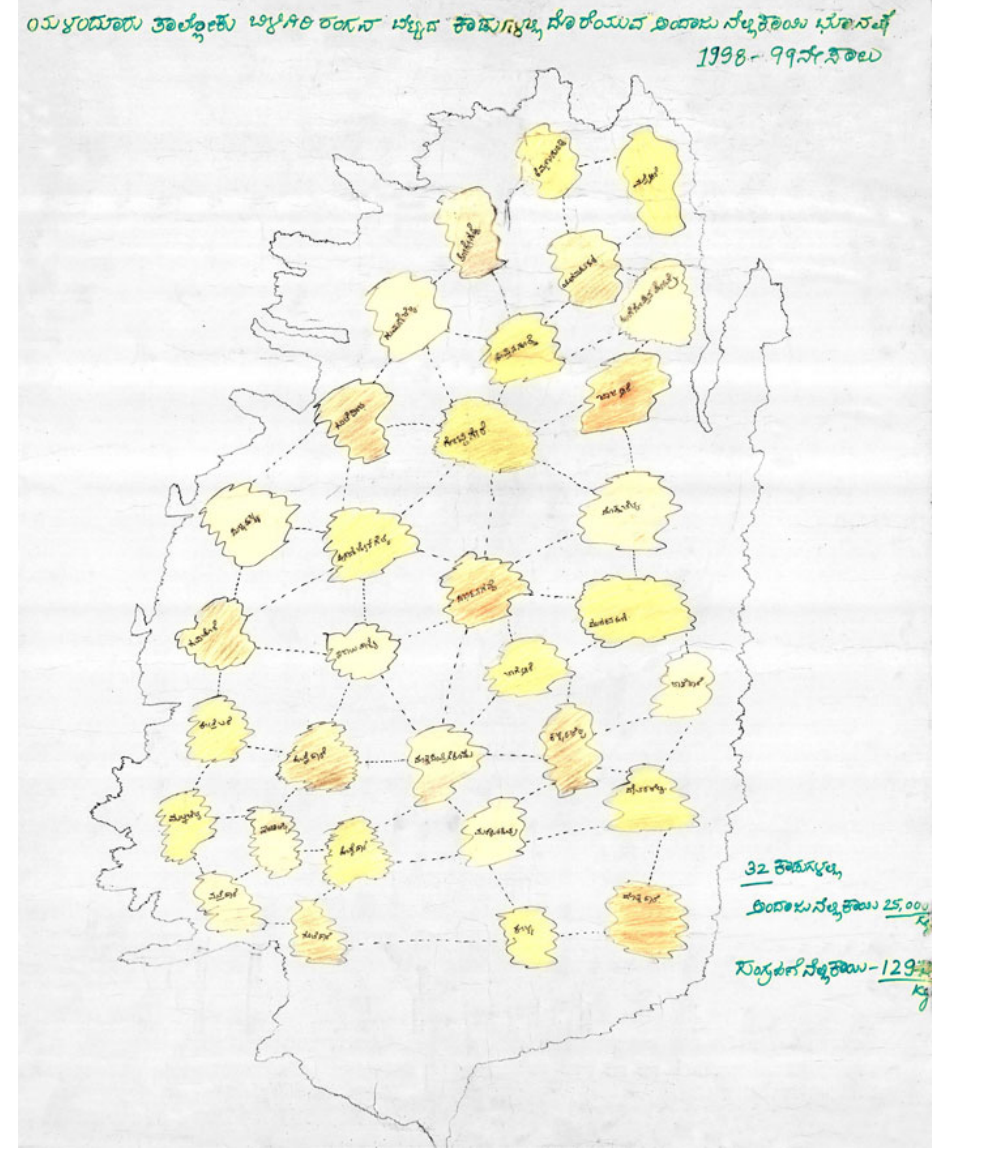
Fig. 2 . Sample of the yearly fruit productivity map prepared by the community. Translated from the Soliga language, the title reads: Estimated quantities of amla fruits available in the forest of BiligiriRangana Betta, Yelandur taluka (range), during 1998–1999. In 1998–1999, amla harvesters from different settlements in theYelandur range of the Biligiri Rangaswamy Temple Wildlife Sanctuary visually estimated the amount of amla fruits produced within their demarcated land of 11,000 ha. The names of 32 forest areas were mentioned by the harvesters and recorded on the map, as is the total quantity of estimated amla fruit produced (25 t) and extracted (12.9 t) that year. In each of eight settlements, 10–15 Soliga harvesters were involved in the estimation of fruit production and extraction for their forest regions, which were then combined to create the total indicated on the map. Therefore, in total some 70 to 120 people were involved in preparing this